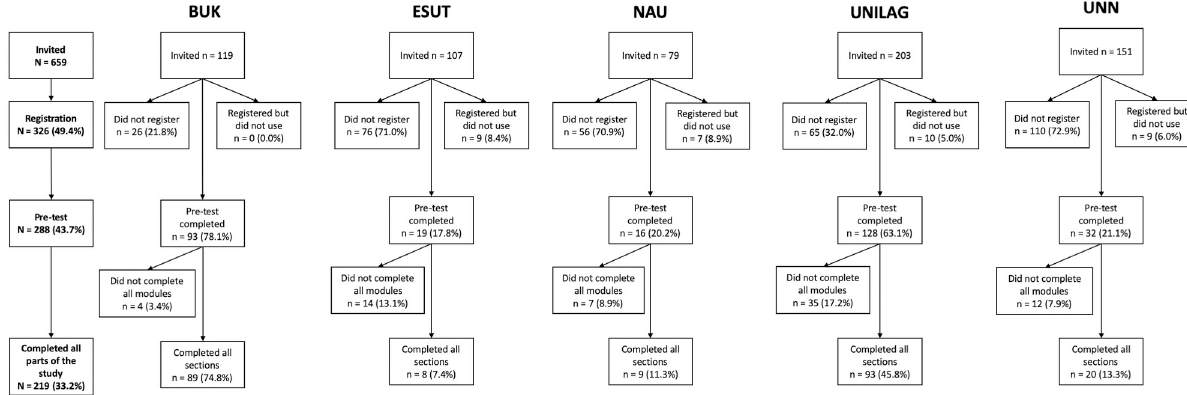
Fig 2. Summary of participation across different stages of study completion.